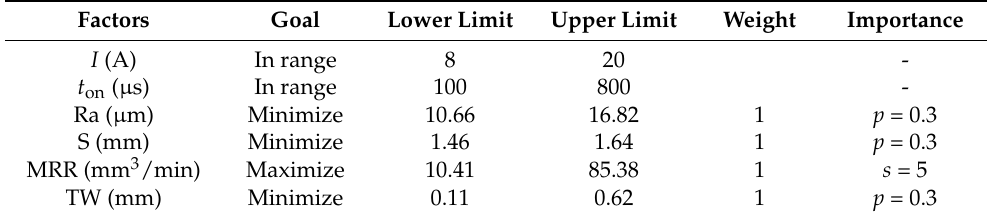
Table 10. Goals and factor range for optimization.